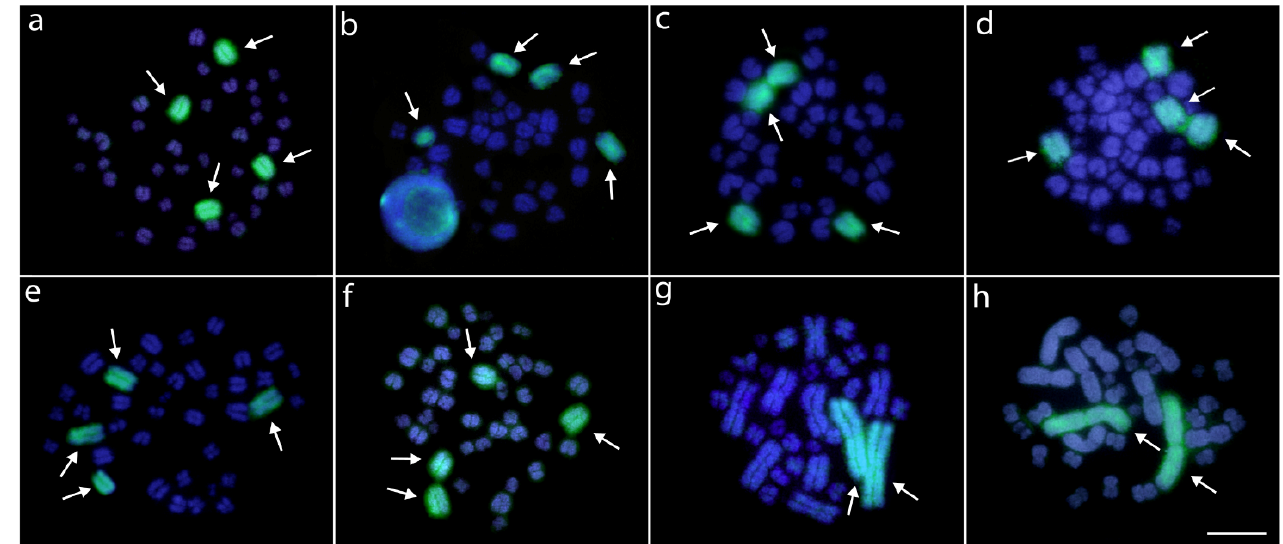
Figure 6. Zoo-FISH experiments with the AMI-1 painting probe (green) applied against female metaphase plates of Caiman crocodilus ( a ), C. latirostris ( b ), C. yacare ( c ), Melanosuchus niger ( d ), Paleosuchus palpebrosus ( e ), P. trigonatus ( f ), Alligator mississippiensis ( g ), and A. sinensis ( h ). Chromosomes were counterstained with DAPI (blue). Arrows indicate the chromosomes painted with AMI-1 probe. Bar = 20 µm.